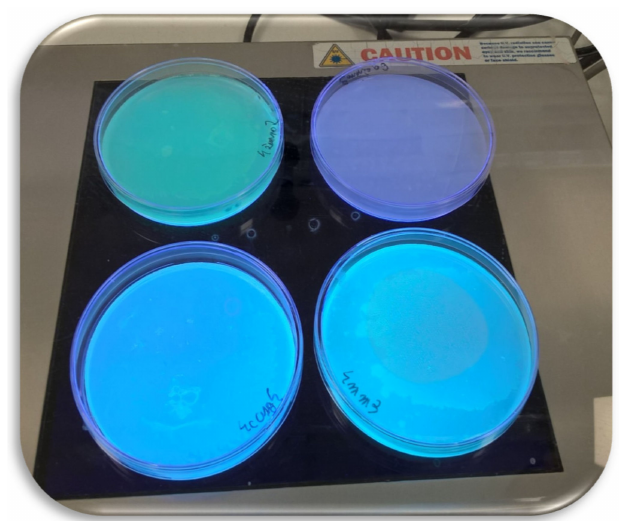
Figure 2. Example of fluorescence intensity of pigments produced by Pseudomonas sp. WG 7, WG 14 and WG 40, respectively, relative to control (purple plate), after 5 days of